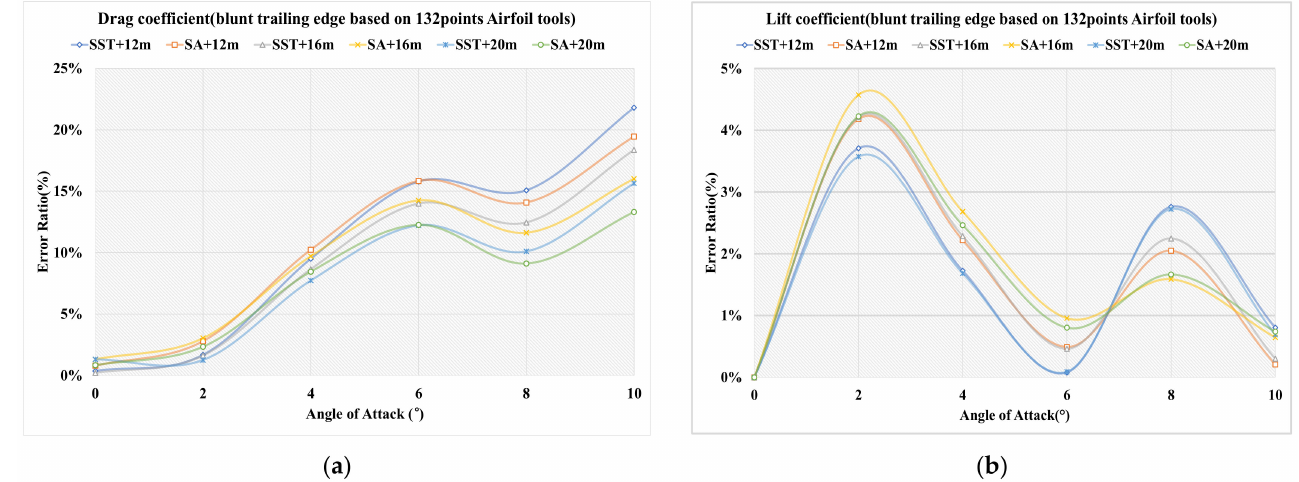
Figure 6. ( a ) Drag coefficient of blunt trailing edge based on Airfoil Tools; ( b ) lift coefficient of blunt trailing edge based on Airfoil Tools.